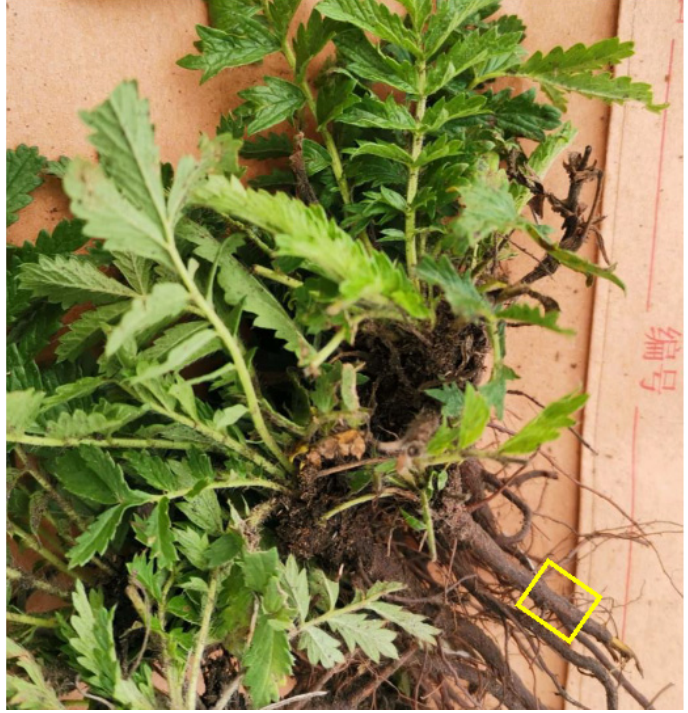
Figure 1. The picture of the research material ( Potentilla tanacetifolia ). The yellow box indicates the intercepted part.